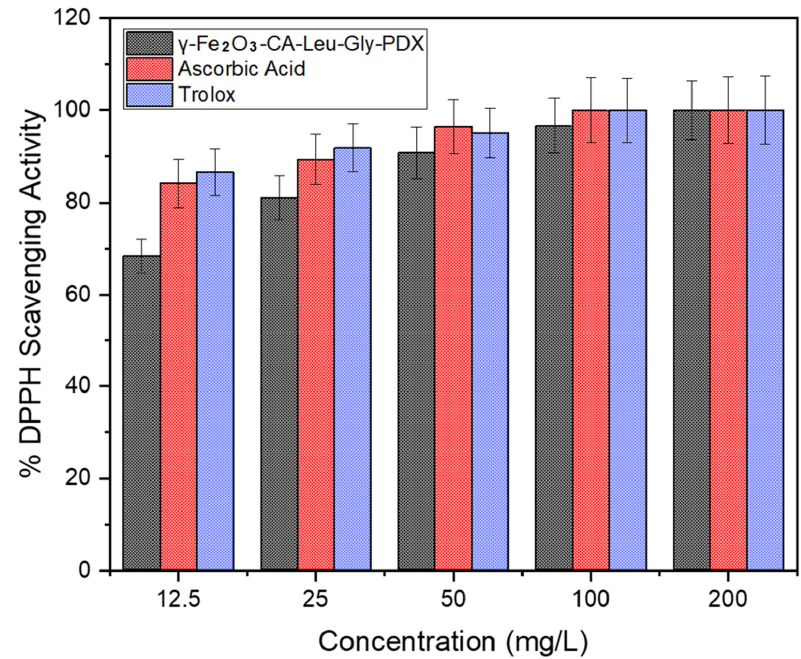
Figure 2. DPPH scavenging activity of γ‐ Fe 2 O 3 ‐ CA ‐ Leu ‐ Gly ‐